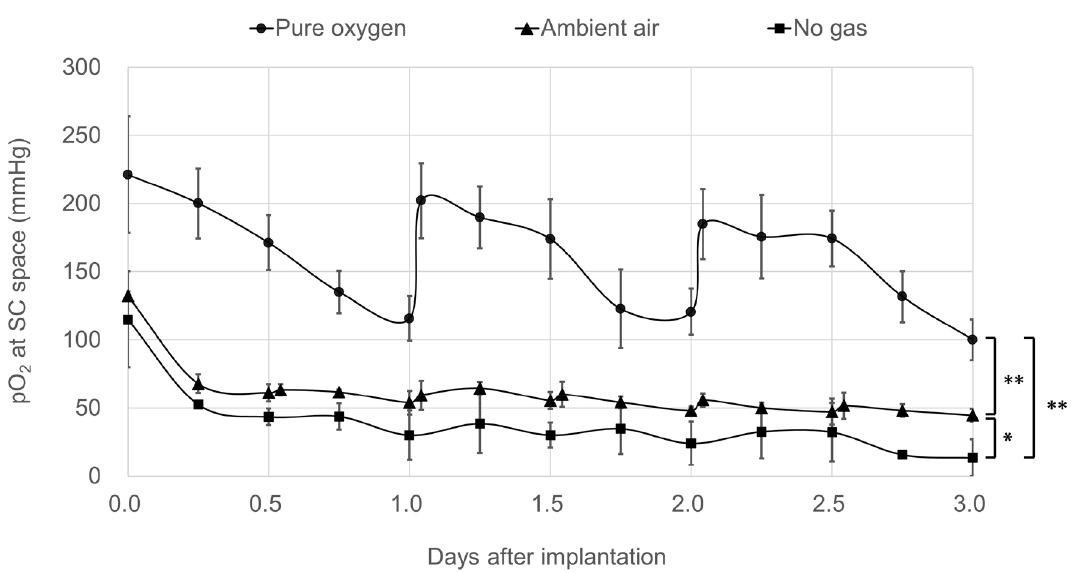
Figure 4. Continuous measurement of pO 2 at the subcutaneous space using an optical sensor system under several oxygenation conditions. In the Pure oxygen group, the pO 2 of the SC gradually decreased after device implantation, but promptly increased again after additional oxygenation. In the Pure oxygen group (circle, n = 6), the pO 2 of the SC was maintained at significantly higher levels in comparison to the Ambient air (triangle, n = 5) and No gas (square, n = 6) groups during the observation period (**p < 0.01, One-way ANOVA with post- hoc Tukey–Kramer Test). The